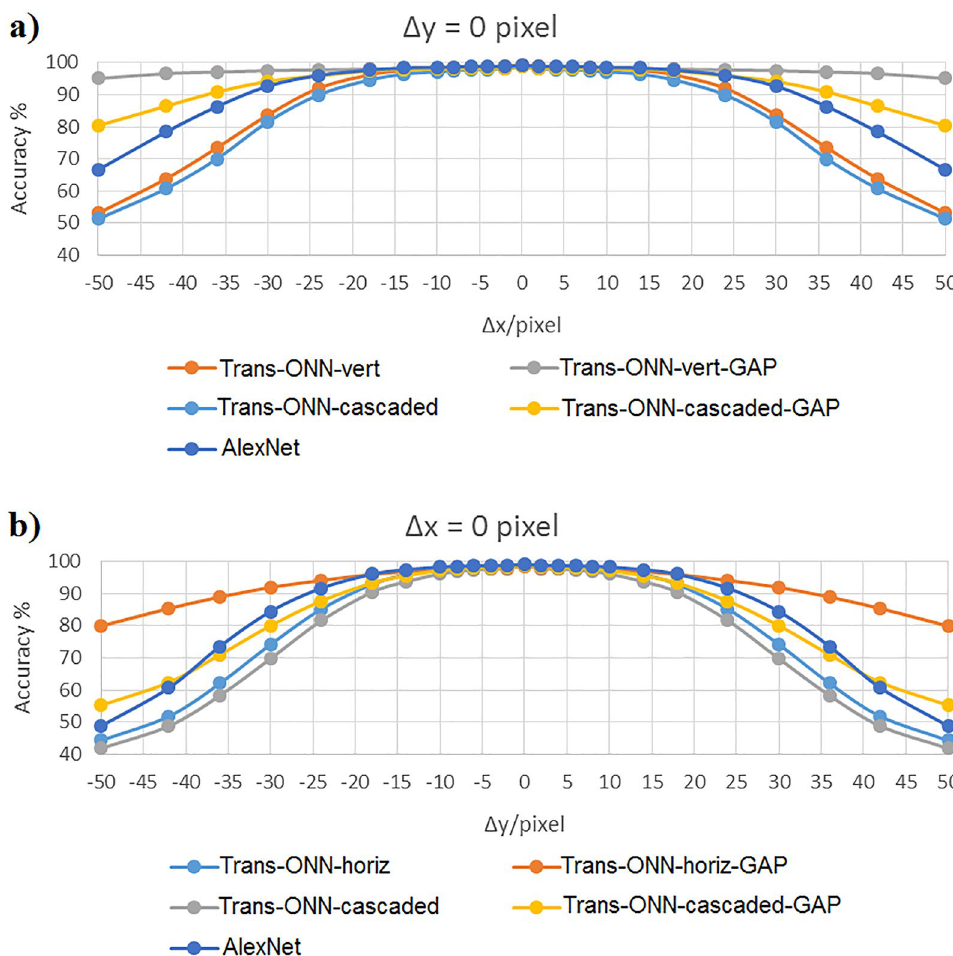
Figure 12. Classification accuracy of MNIST dataset by considering ( a ) vertical mask, and ( b ) horizontal